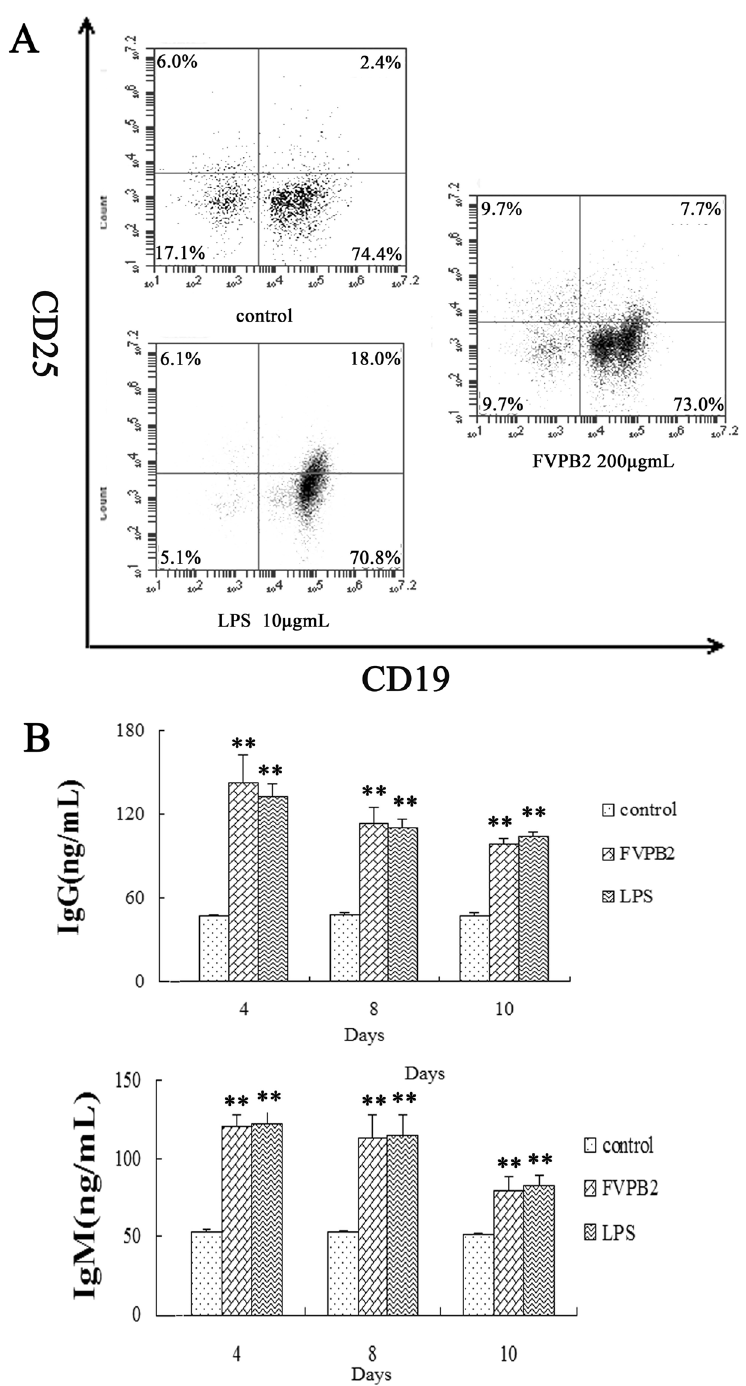
Figure 4. Identification of activation of B lymphocytes treated by FVPB2. ( A ) The activated B lymphocytes were identified with anti-CD19-PE and anti-CD25-APC. ( B ) Secretion of IgG and IgM by mouse spleen lymphocytes incubated with FVPB2. Mouse spleen lymphocytes were incubated with 200 μ g/mL FVPB2, 10 μ g/mL LPS or PBS. Each value represents the mean ± SD of separate triplicate experiments. Values were significantly higher than those of controls are indicated by * P < 0.05 and ** P <